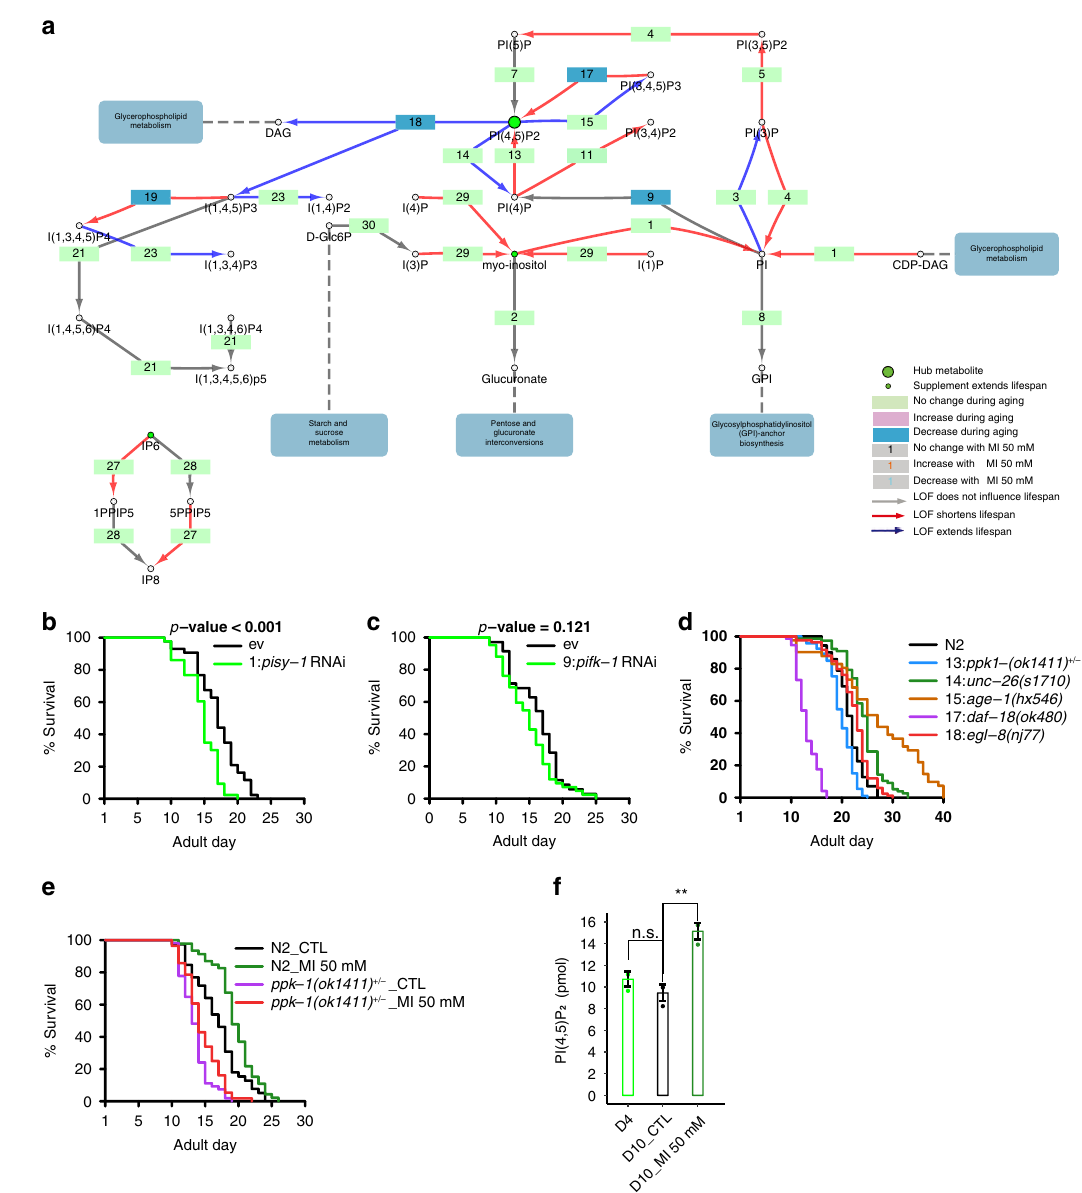
Fig. 4 PI(4,5)P2 is the effector of MI. a MI metabolic pathway in C. elegans . The arrowhead shows the reaction direction. The number labels the reaction step, which can be catalyzed by one or more enzymes. Red arrows indicate LOF of the enzyme shortened lifespan, cyan is the opposite with only log-rank test p < 0.05 results labeled. The color of the enzyme node shows the mRNA increased (plum) or decreased (blue) with age. The label color of the reaction number indicates MI supplementation increased (purple) or decreased (cyan) the enzymes ’ transcripts. Only results with log 2 fold change > 0.26 are labeled. b , c Survival curves of empty vector control, pisy-1 RNAi (log-rank test p = 4.30E-05, N = 2), and pifk-1 RNAi worms (log-rank test p = 0.121, N = 3), respectively. d Survival curves of control and mutant worms with LOF enzymes producing or degrading PI(4,5)P 2 . (13: ppk - 1(ok1411) + / − , log-rank test p = 1.02E-04, N = 5; 14: unc - 26(s1710) , log-rank test p = 2.23E-08, N = 6; 15: age - 1(hx546) , log-rank test p = 5.41E-08, N = 4; 17: daf - 18(ok480) , log-rank test p = 1.54E-35, N = 8; 18: egl - 8(nj77) , log-rank test p = 3.33E-11), N = 6. e ppk-1 heterozygous mutant partially blocked MI longevity effect, N = 2. f ELISA results show PI(4,5)P 2 level decreased during worm aging (Data are presented as mean values ± SEM, n.s. p = 0.20), and was reversed by MI supplement on AD_10 (two-sided t -test ** p = 0.003), N = 3. Source data are provided as a Source Data fi